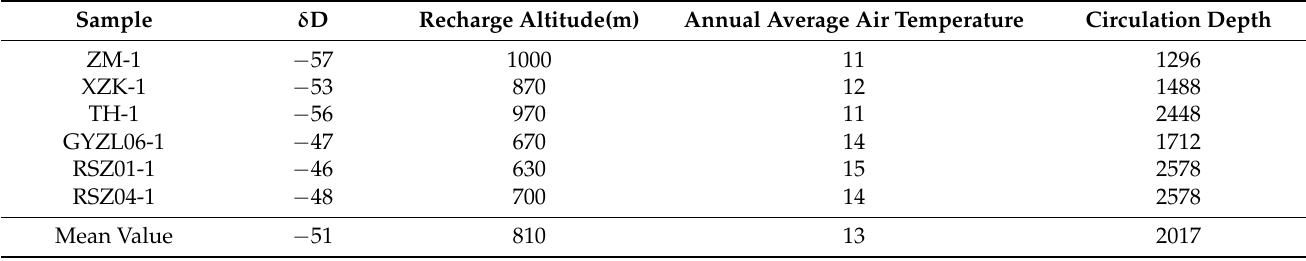
Table 6. Estimated recharge altitude and circulation depth is shown in (m), annual average